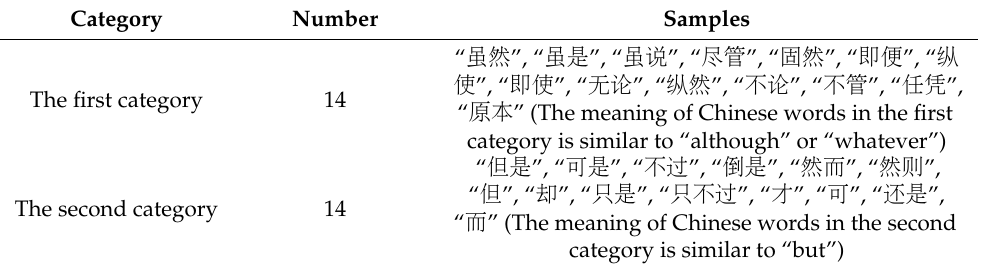
Table 2. The list of adversative